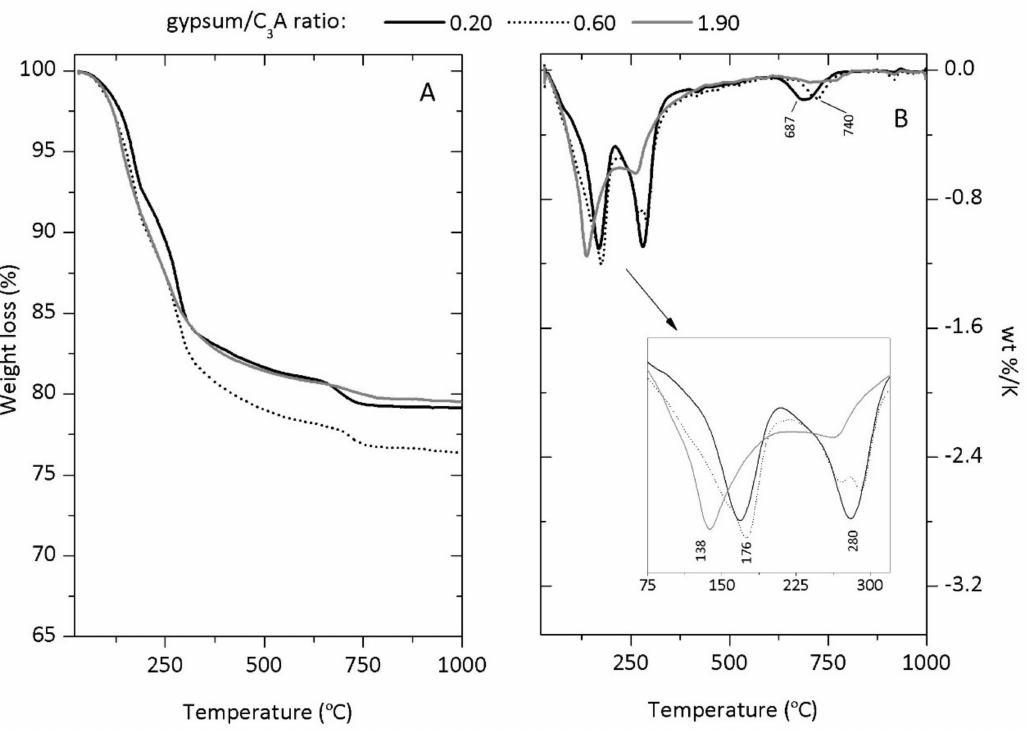
Figure A3. Weight loss curve profiles determined by ( A ) TGA and ( B ) DTG of different gypsum contents on orth-C 3 A